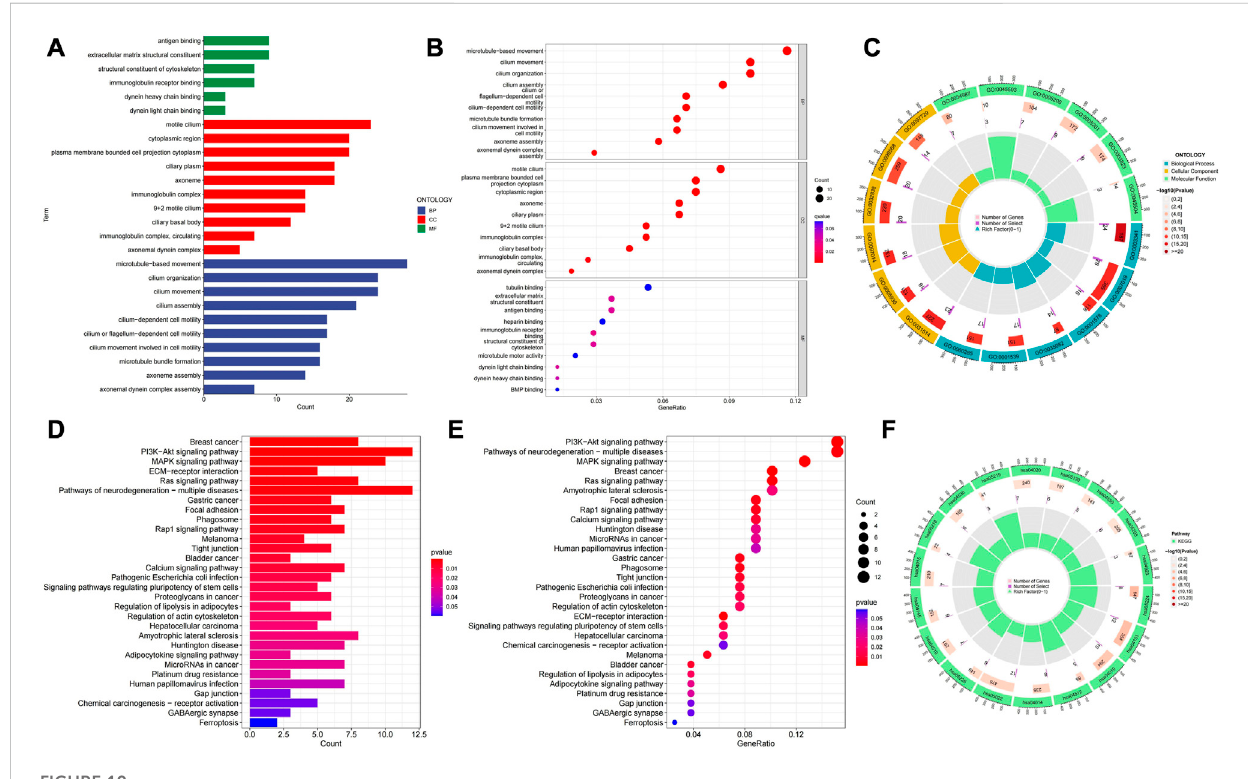
FIGURE 10 (A – C) GO enrichment analysis. (D – F) KEGG enrichment